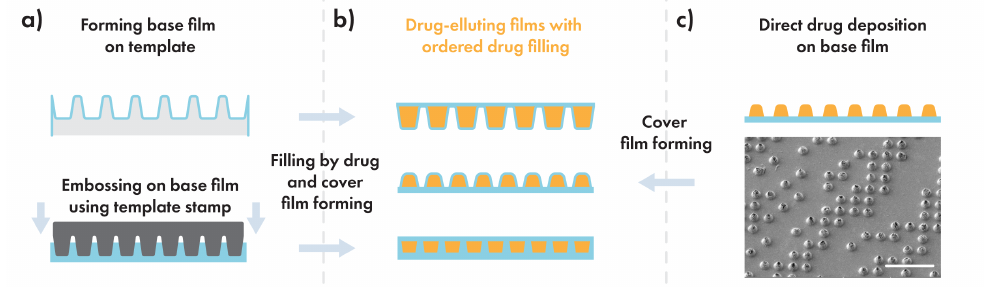
Figure 2. Simplified process of DEFs production. ( a ) Template-based methods, ( b ) DEFs represented as array of microcontainers filled with drugs and sealed between two polymer films, ( c ) direct drug deposition approach and SEM image of drug deposited onto flat PLA film as separate piles using the PDMS stamp-assisted transfer method; scale bar 100 µ m